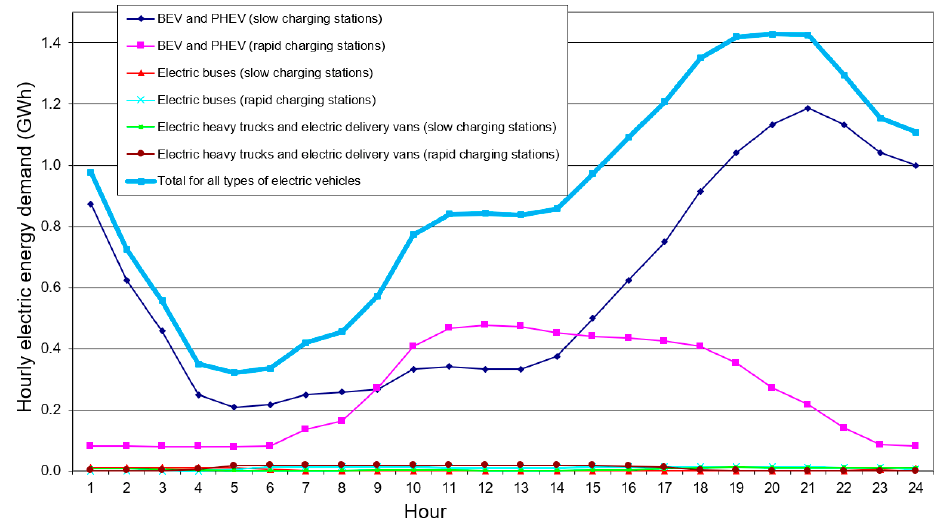
Figure 16. Daily profiles of power demand for charging EVs—balanced variant of the forecast number of EVs in 2027.